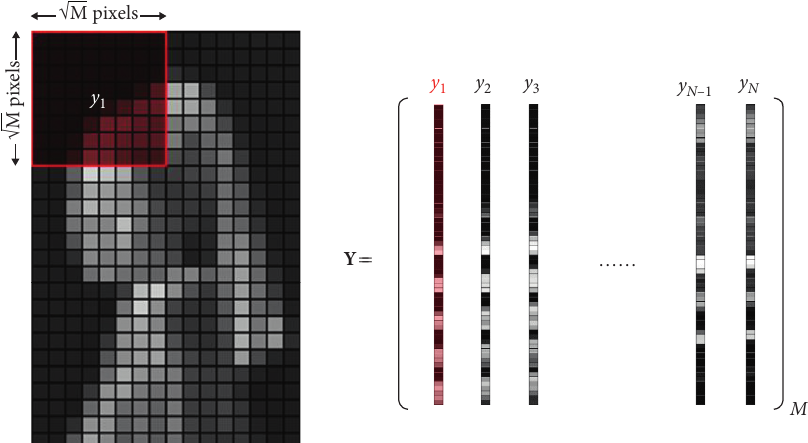
Figure 3: Illustrative diagram of an example set. The example set Y consists of small patches y be overlapping or nonoverlapping and are converted to column vectors. In this paper, the patches are extracted by a sliding window with a stride.